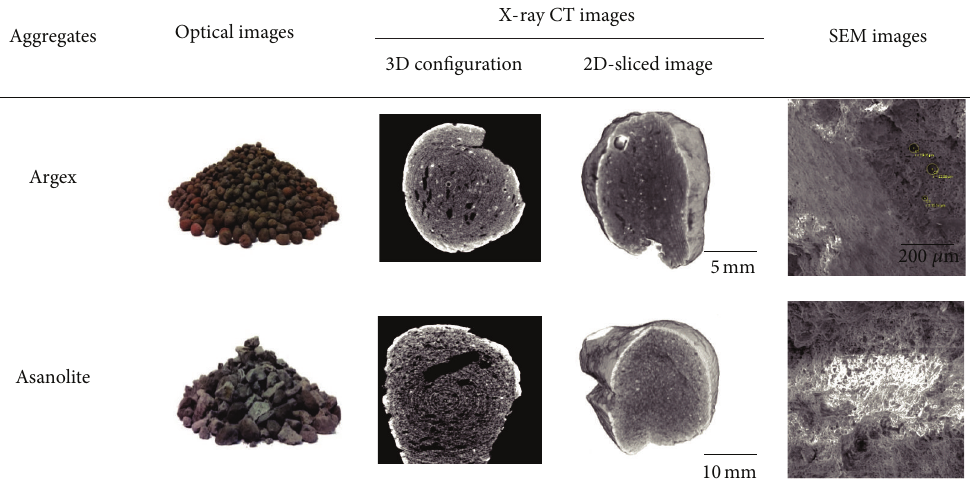
Figure 1: Images of lightweight coarse aggregates.